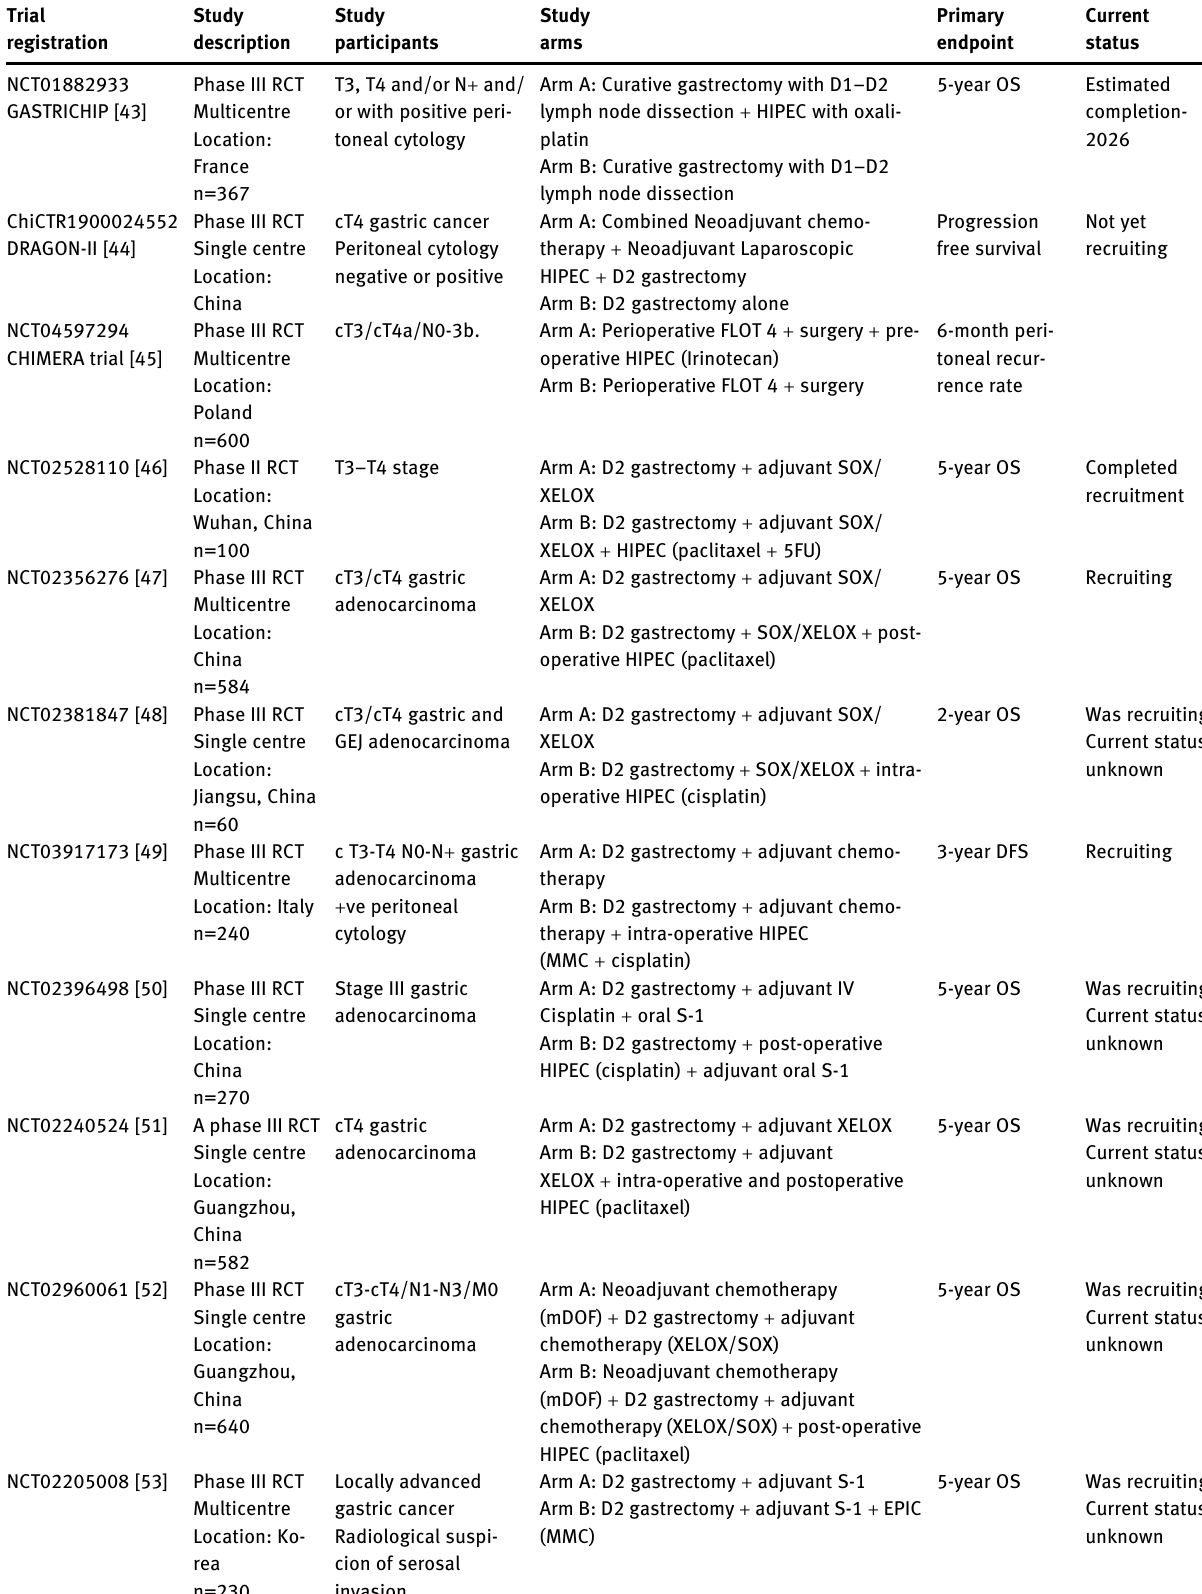
Table  : Ongoing clinical trials for p-HIPEC.